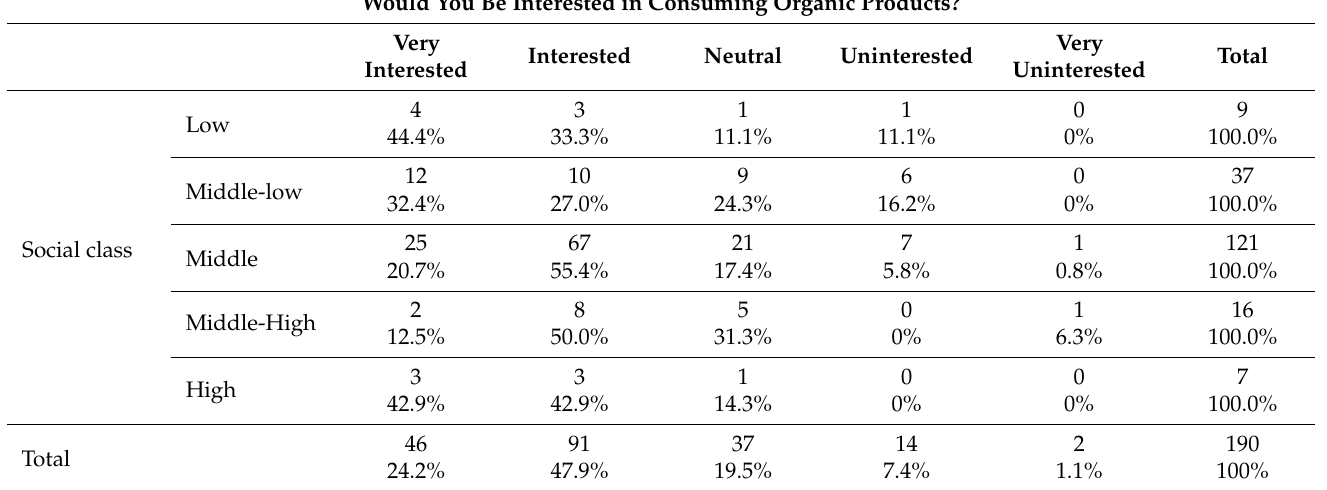
Table 2. Association between social class and interest in consuming organic